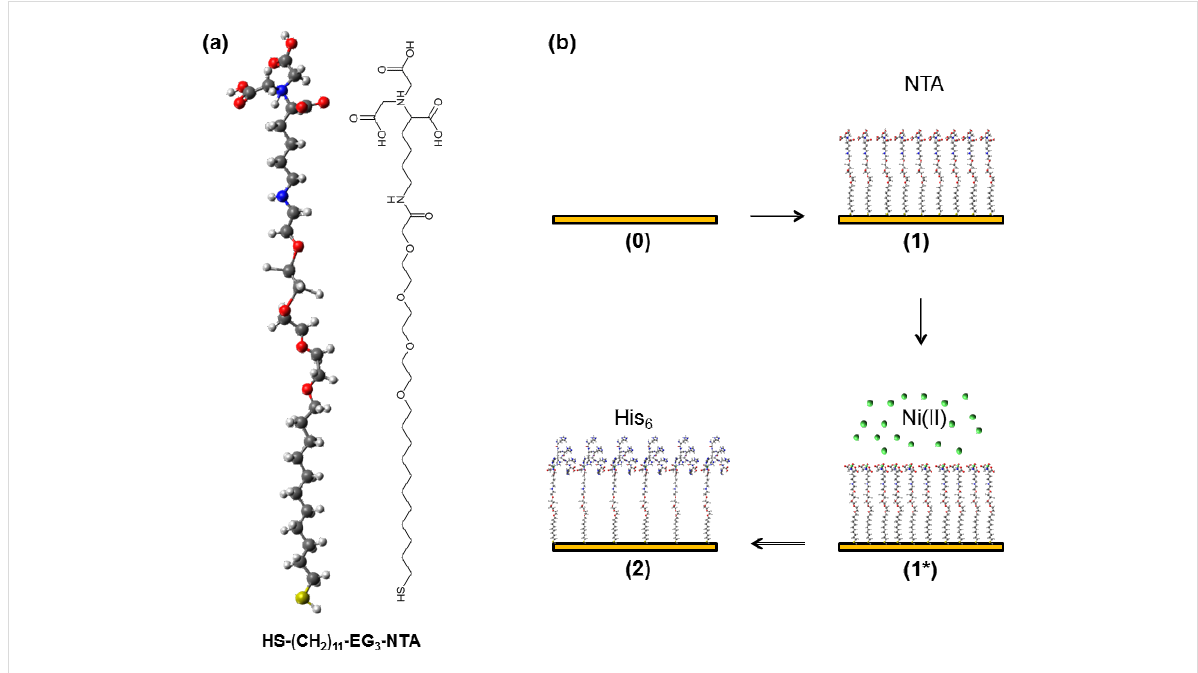
Figure 1: (a) Chemical structure of the HS-C11-EG3-NTA (NTA1) molecule; (b) sketch of the steps of sample preparation: (0) substrate preparation, (1) formation of the NTA SAM, (1 * ) Ni(II) loading and (2) adsorption of His 6 . Step (1 * ) was skipped for a subset of samples in order to check non-spe- cific His 6 –NTA interactions. The ellipsometry analysis focused on steps (0), (1), (2).